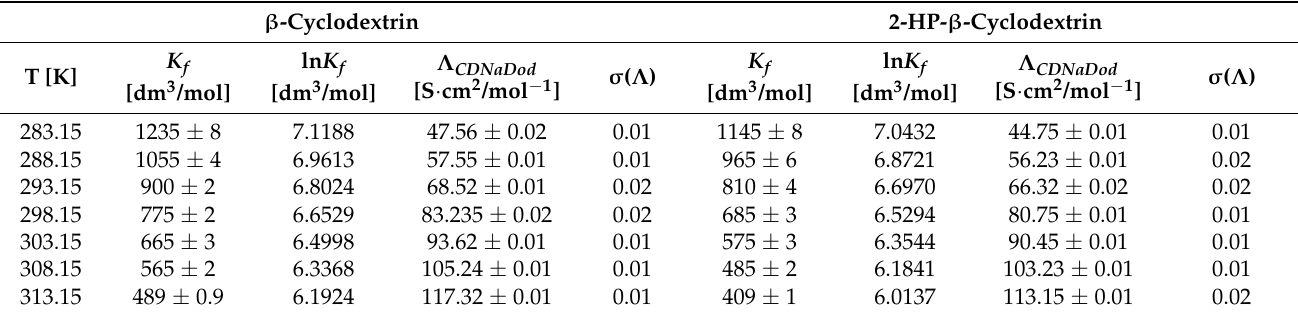
Table 1. The value of constant formation K f [dm 3 /mol], theoretical conductivity Λ CDNaDod [S · cm 2 /mol − 1 ] for β -cyclodextrin and 2-HP- β -cyclodextrin with the salt of trans -cinnamic acid.